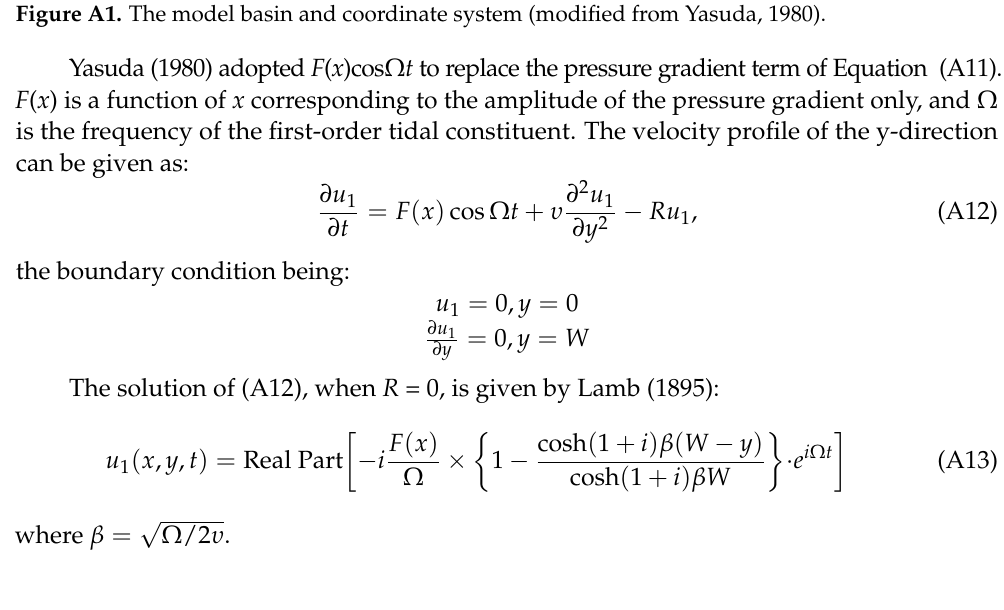
Figure A1. The model basin and coordinate system (modified from Yasuda,